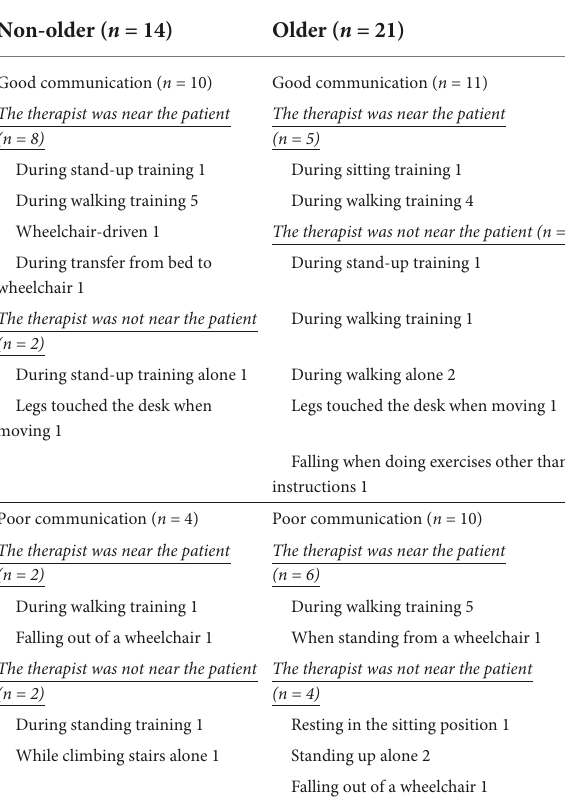
TABLE 3 About the communication ability of the patient at the time of the fall and details of the fall situation.